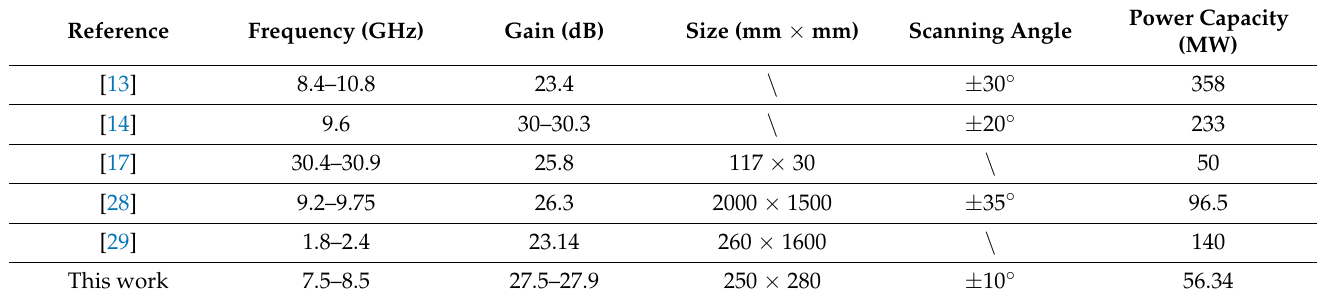
Table 2. The comparison of the proposed HPM active phased array antenna and other HPM